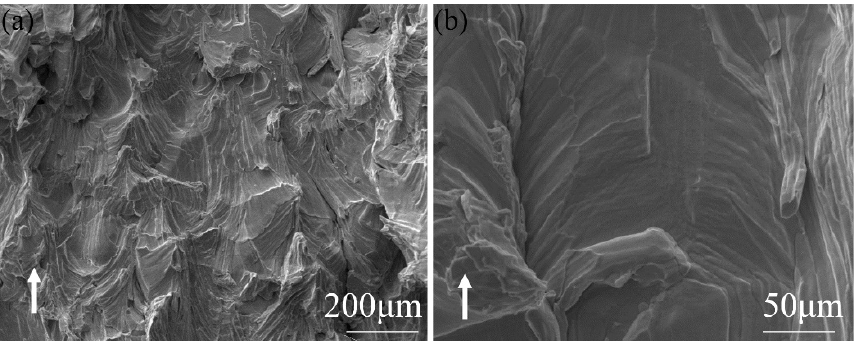
Figure 10. SEM image of fracture surface perpendicular to the building direction of Mo. ( a ) low- magnification, ( b ) high-magnification